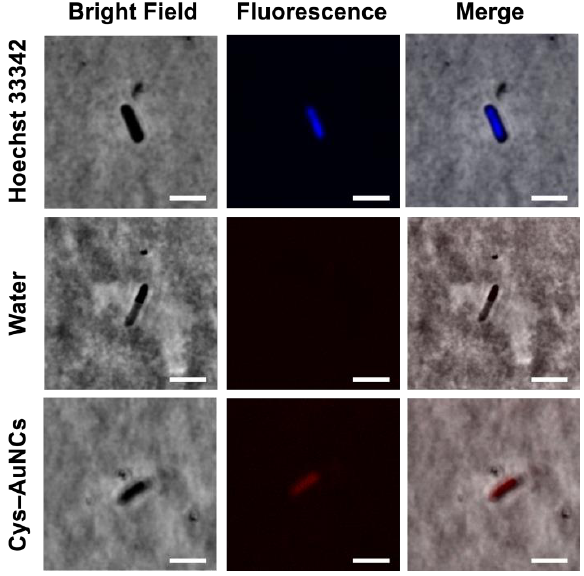
Figure 7. Confocal microscopic images of the E. coli . The blue and red pseudocolors represent